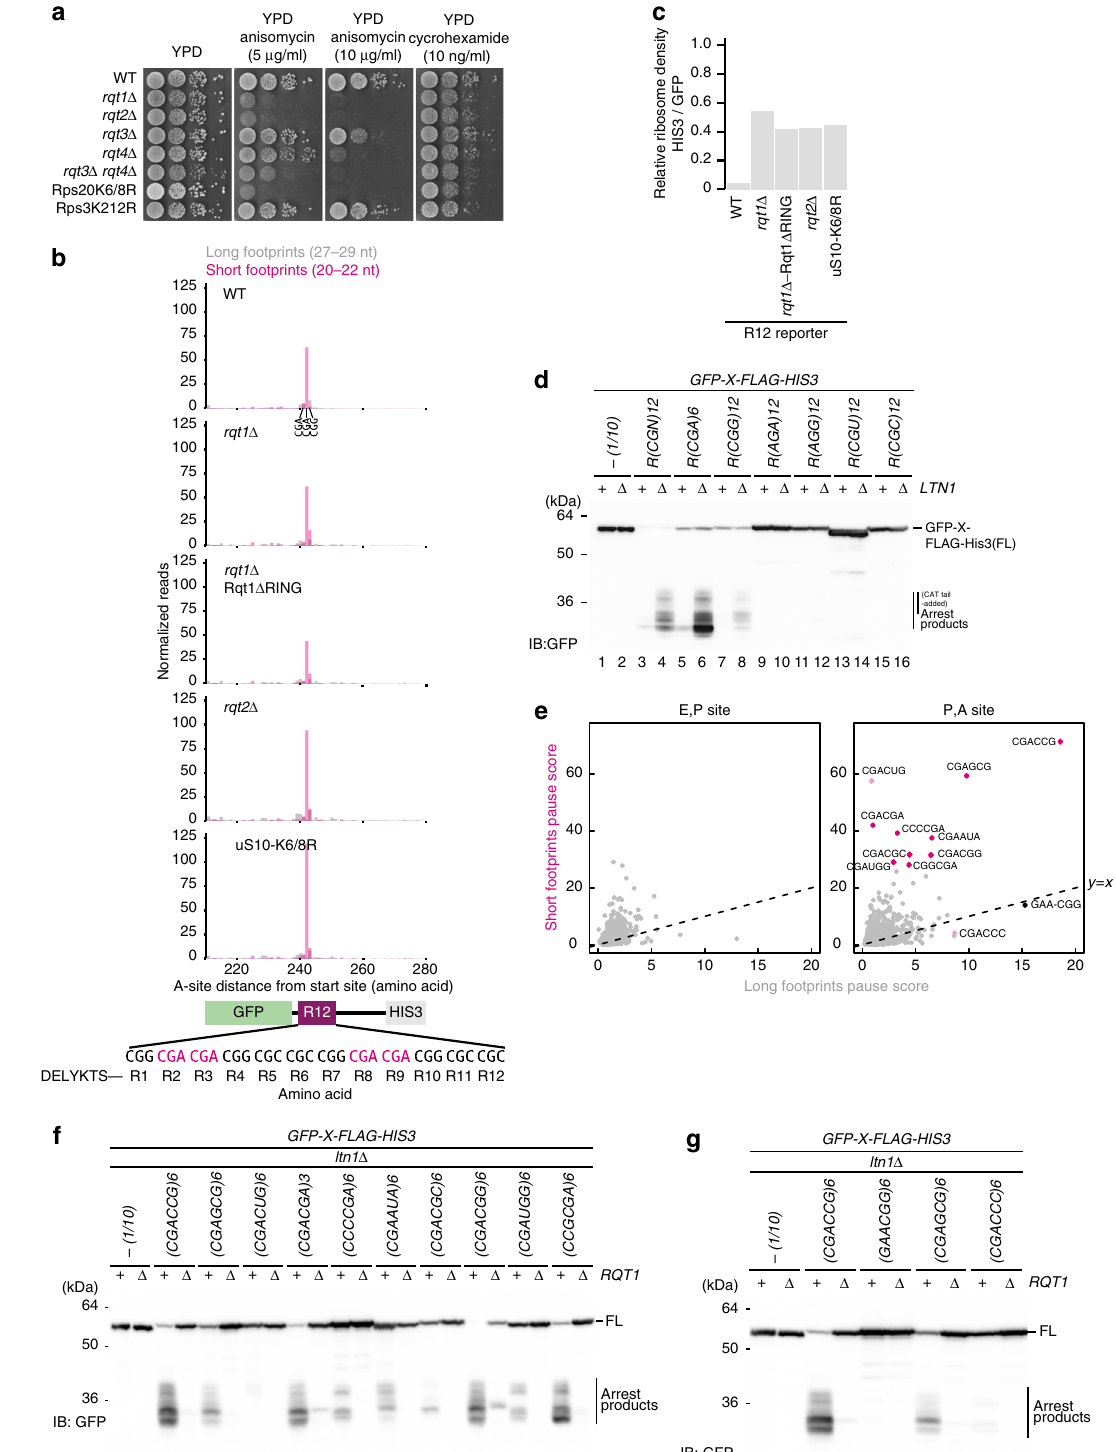
Fig. 5 Stalled ribosomes in a rotated state conformation are targets for RQC. a The anisomycin sensitivity of rqt and uS10-K6/8R mutants. b Ribosome short footprints were accumulated at CGA-CGA codons. The short footprints and long footprints from the ribosome pro fi ling data set were mapped on the reporter gene ( GFP-R12-FLAG-HIS3 ). The reads were plotted at approximate position of ribosome A-site. c Translation of HIS3 downstream of R(CGN)12 arrest-sequence was increased in the rqt and uS10-K6/8R mutants. d Codon speci fi city of poly-arginine sequence to induce translation arrest and RQC. e Speci fi city of di-codons for accumulation of short and long footprints. f GFP-X-FLAG-HIS3 reporter assay of Top 10 di-codons in the accumulation of short footprints. g GFP-X-FLAG-HIS3 reporter assay of top 4 di-codons in the accumulation of long footprints